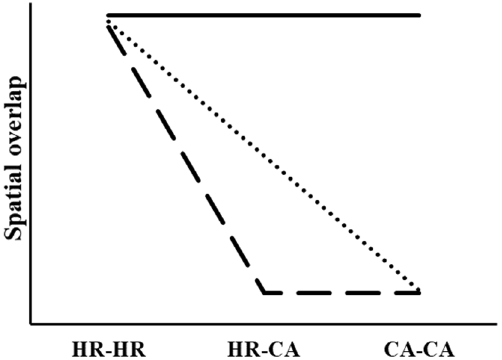
Figure 1. Predicted relationships evaluating territoriality among animals based on spatial overlap in home ranges (HR) and core areas (CA). Interactions can occur between two individual’s home ranges (HR–HR), between one individual’s home range and another individual’s core area (HR–CA), or between two individual’s core areas (CA–CA). If animals are not territorial, spatial overlap is expected to be the same across HR–HR, HR–CA, and CA–CA comparisons (solid line). If animals are territorial, it is expected that spatial overlap will decrease between HR–HR and HR–CA comparisons [dashed line; consistent with Burt (1943) and Schoener (1968)] or among HR–HR, HR–CA, and CA–CA comparisons [dotted line; consistent with Gabor et al. (1999), Darden and Dabelsteen (200), and Pierro et al.